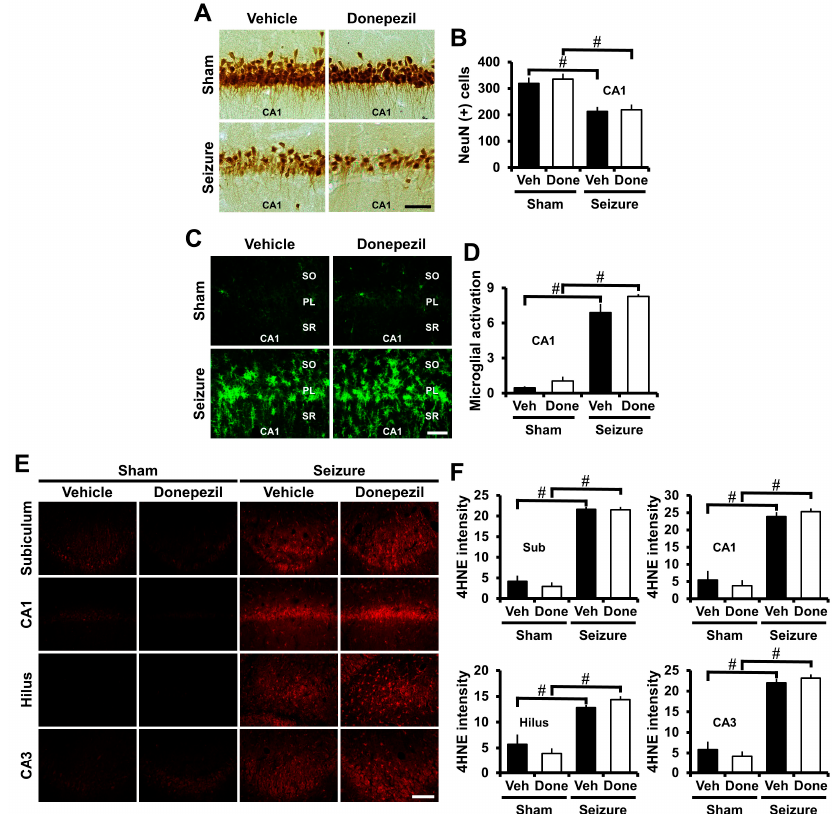
Figure 2. Post-treatment of donepezil for one week showed no effects on seizure-induced neuronal death, oxidative injury, and microglia activation. ( A ) Representative images indicate the NeuN (+) live neurons in the CA1 of the hippocampus. There was no difference in the number of live neurons between the vehicle-treated and donepezil-treated group after seizure. Scale bar = 50 μ m; ( B ) The bar graph shows the number of NeuN (+) live neurons; ( C ) Fluorescent images indicate microglia activation in the CA1 of the hippocampus. There was no difference in microglia activation between the seizure vehicle and donepezil groups. Scale bar = 50 μ m; ( D ) The bar graph was obtained by scoring the activation of microglia; ( E ) Fluorescent images indicate oxidative injury in the CA1, CA3, hilus, and subiculum of the hippocampus. There was no difference in the intensity of oxidative injury between the seizure vehicle group and donepezil group. Scale bar = 100 μ m; ( F ) The bar graph shows the intensity of the oxidative injury. n = 5 from each sham group. n = 8–10 from each seizure group. # Significantly different from vehicle treated group. # p < 0.05.